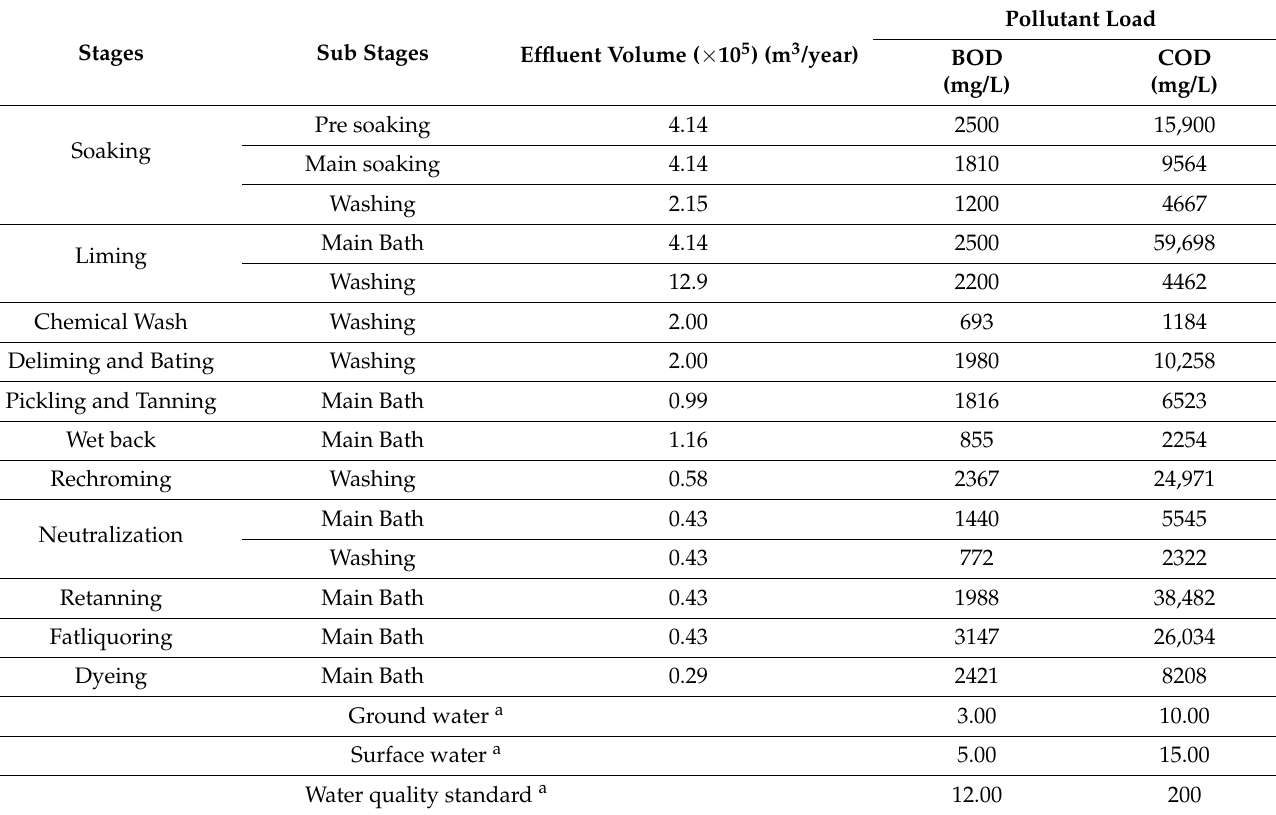
Table 2. Pollutants concentration in effluent from each stage of tanneries and in groundwater, surface water, and ambient water quality